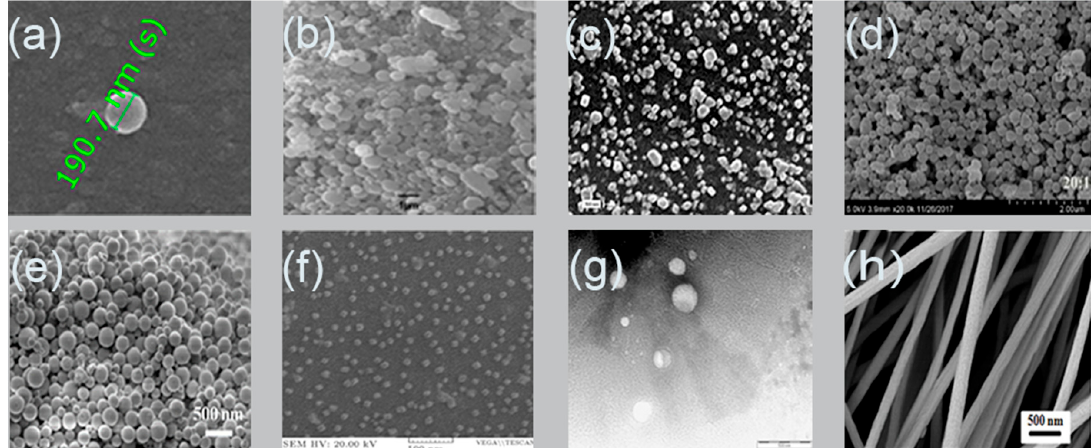
Figure 2. Scanning electron microscopy images of alginate nanoparticles prepared by: ( a ) emulsification/internal gelation, 1% w / w alginate, CaCO 3 :alginate mass ratios 0.1:1, pH 6 medium chain triglyceride (MCT) oil [40]; ( b ) nanospray dryer, spray cap 7 µm, flow rate 7 mL/min, drying gas flow of 110 L/min with relative flow rate 100%, inlet drying gas temperature 120 °C and outlet temperature 35 °C [41]; ( c ) polyelectrolyte complexation, nisin-loaded nanoparticles alginate 250 mg/mL and chitosan 250 mg/mL [42]; ( d ) evaporation method, zein-to-propylene glycol, alginate mass ratio 20:1 [43]; ( e ) layer-by-layer, paclitaxel, poly (lactic-co-glycolic acid) (PLGA) 10 mg/mL, alginate 5 mg/mL and chitosan 5 mg/mL [44]; ( f ) emulsification/external gelation, alginate 0.03% w / v and CaCl 2 18 mM [45]; ( g ) electrospray DNA plasmid loaded alginate nanoparticles, flow rate 0.1 mL/h, voltage 12.5 kV, alginate 1% w / v , Tween 20 1% v / v , CaCl 2 1.5% w / v , collector distance 4 cm and nozzle size 30 G [46]; ( h ) nanofiber produced by electrospinning, alginate 1.74% w / w , voltage 12 kV, needle 27 G, flow rate 0.6 mL/h and distance 12 cm [47].